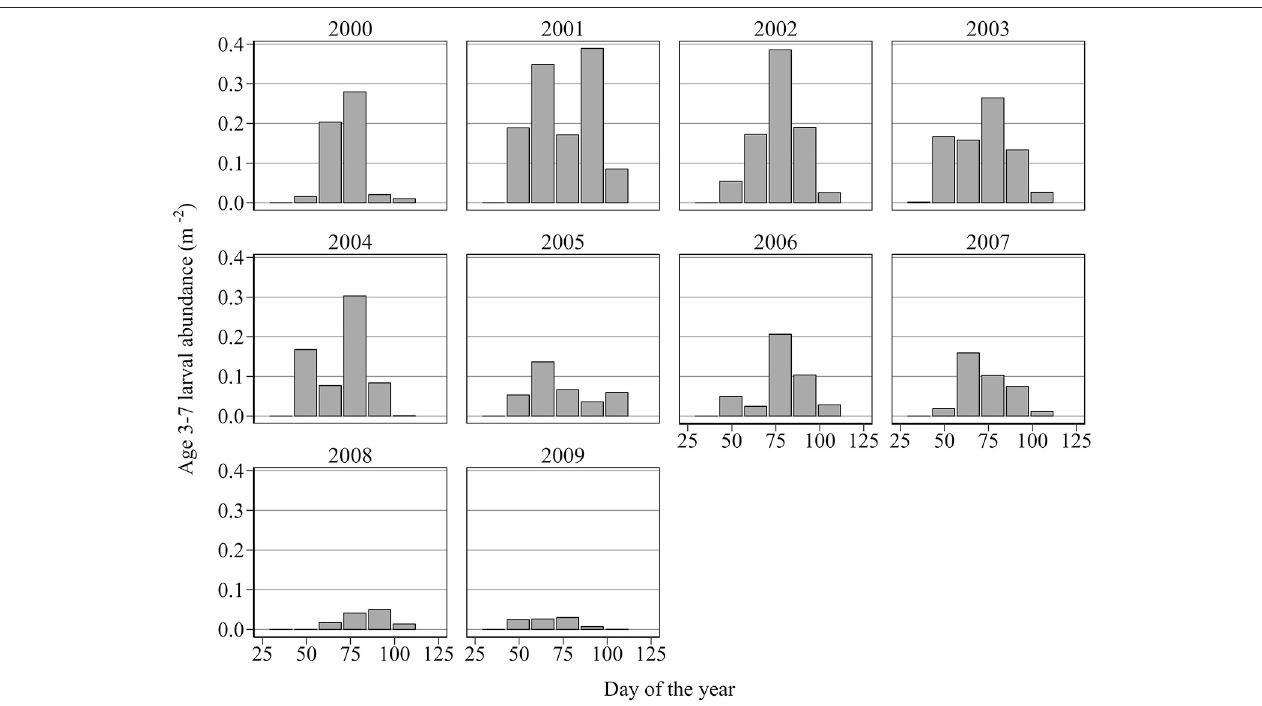
FIGURE 2 | Mean abundance (m − 2 ) of newly hatched larvae (age 3–7 days old when caught) at successive hatch intervals of (days 29–42, 43–56, 57–70, 71–84, 85–98, 99–112, 113–126, and 127–140).